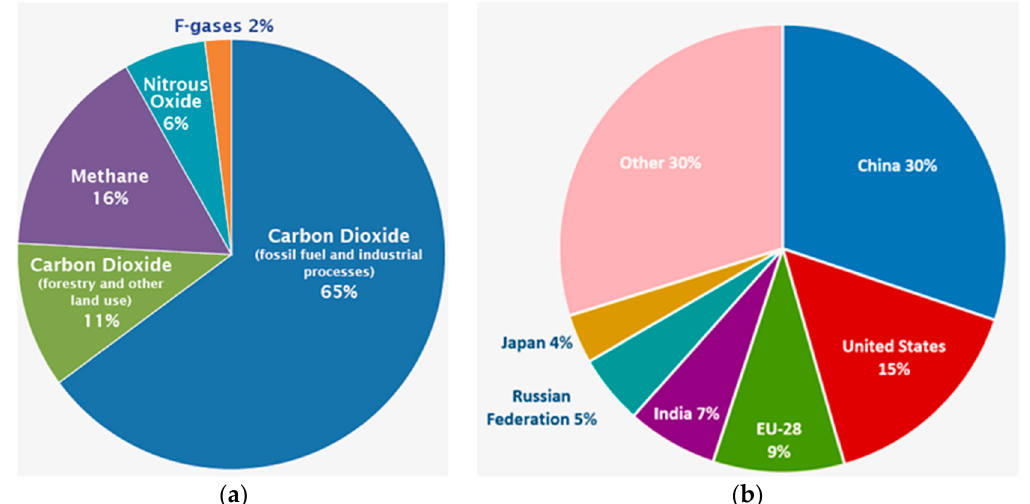
Figure 17. Global GHGs: ( a ) Emission by gas, and ( b ) Emission by country [129].